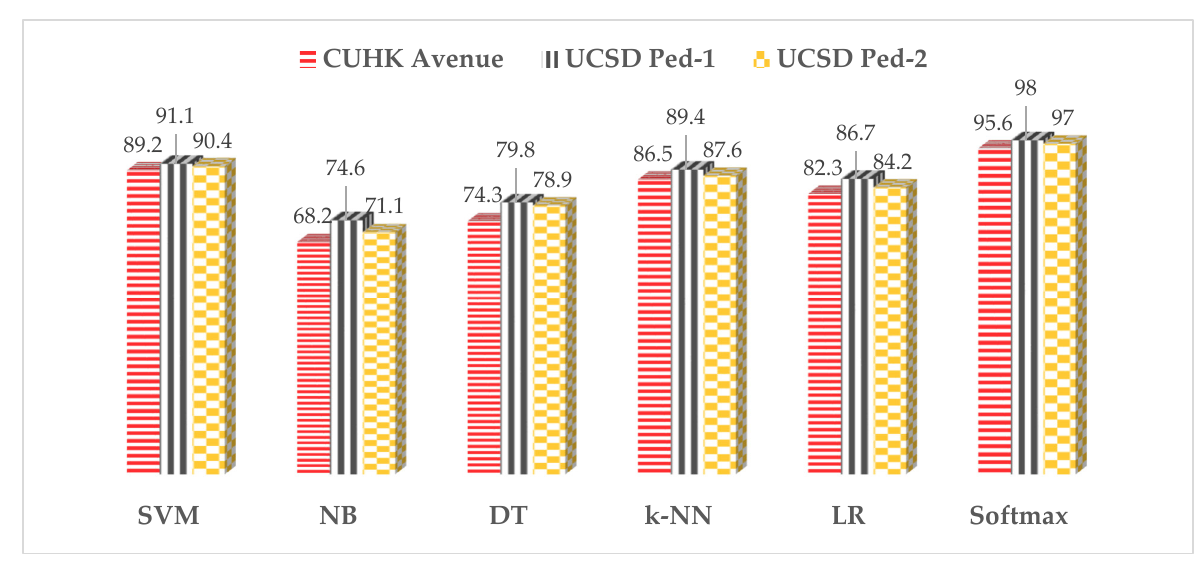
Figure 6. Classification accuracies of ML classifiers on three datasets.